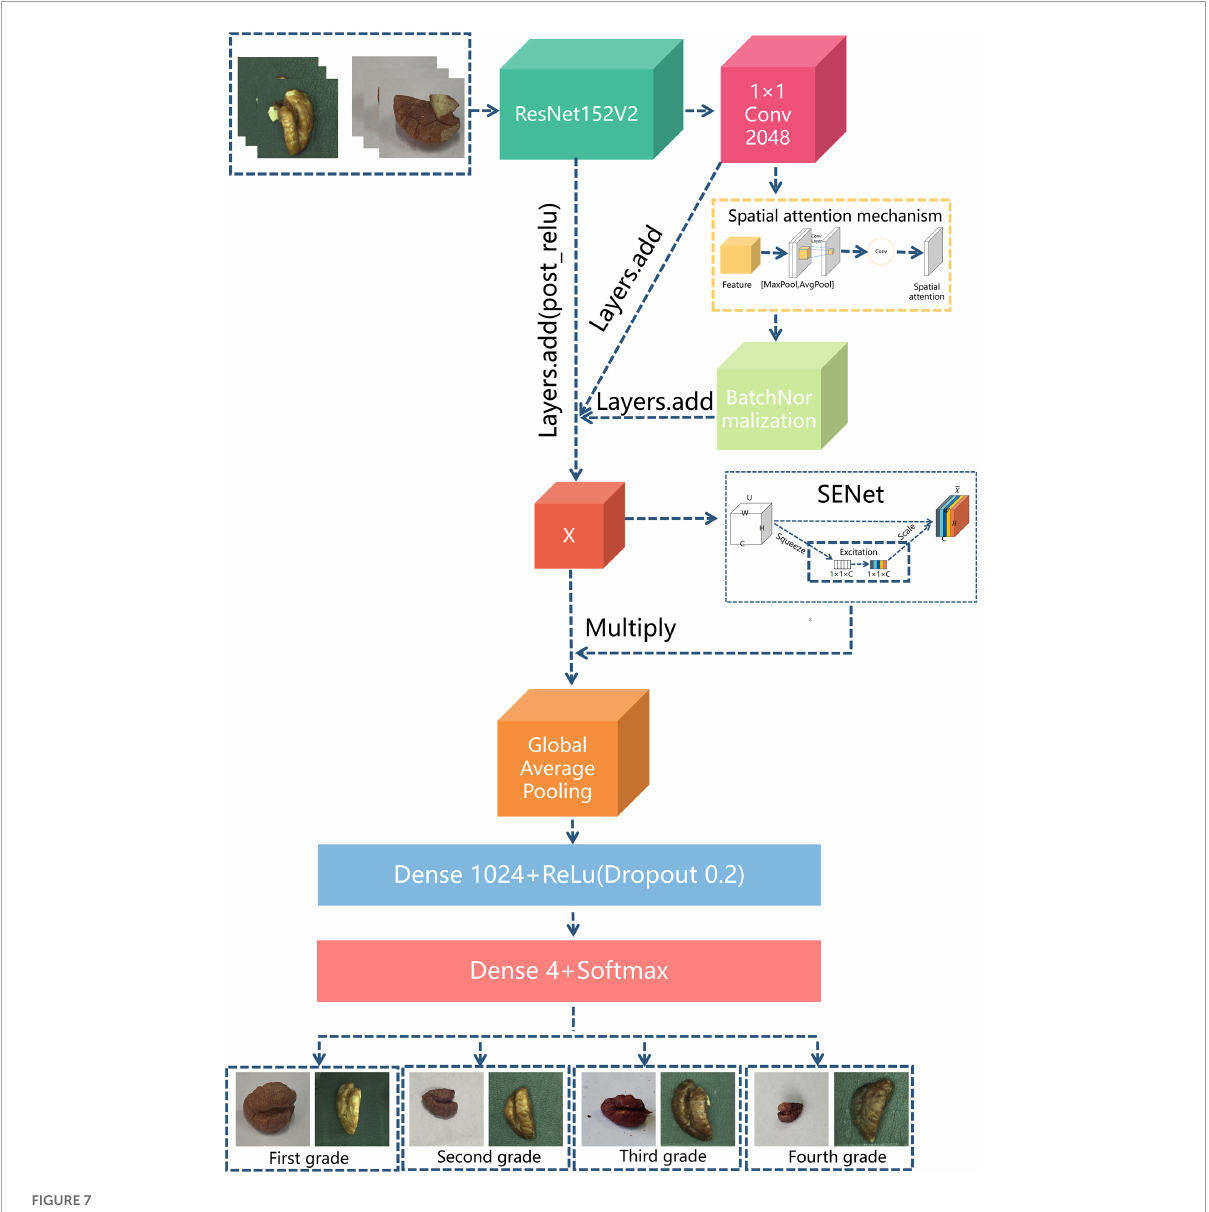
FIGURE7 ResNet152V2-SA-SE network